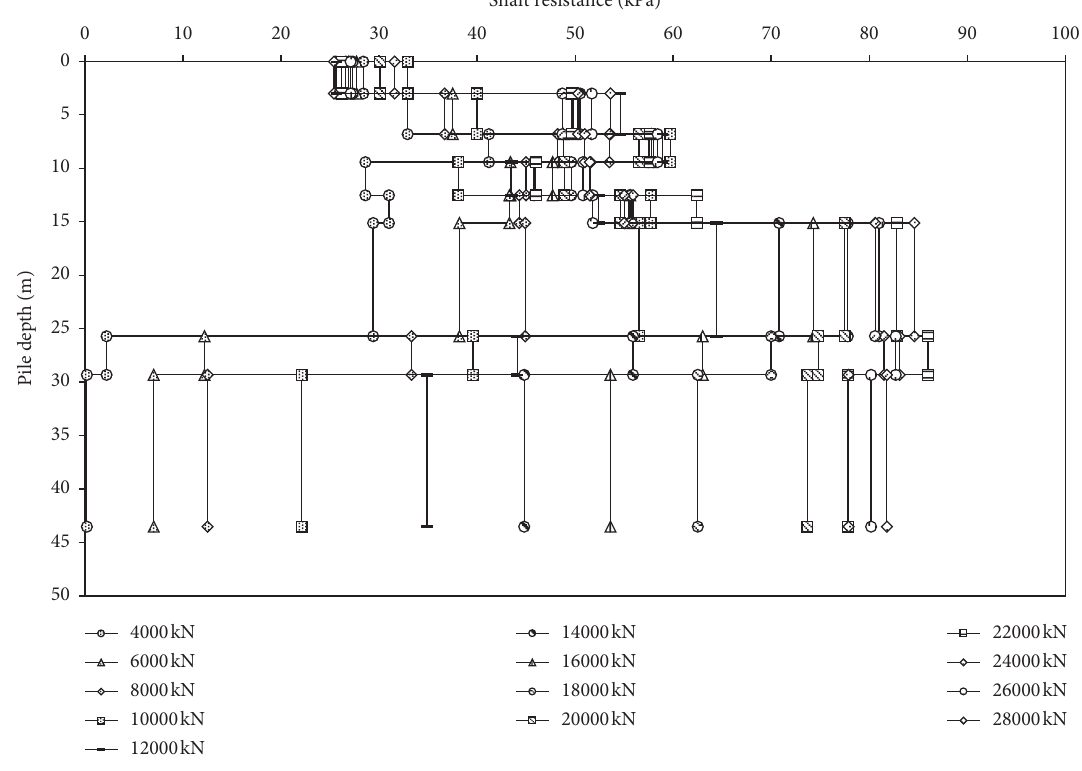
Figure 18: Shaft resistance distribution along the pile for P12.